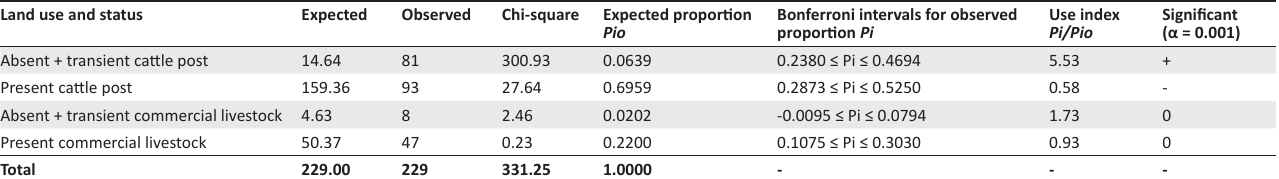
TABLE 3: Bonferroni simultaneous confidence intervals for the presence and absence ortransience of brown hyaena ( Parahyaena brunnea ) based on questionnaires (2008–2009 and 2011–2012) completed by farmers on game ranches ( n = 107), commercial livestock farms ( n = 55) and traditional cattle posts ( n = 174) in the agricultural zones of